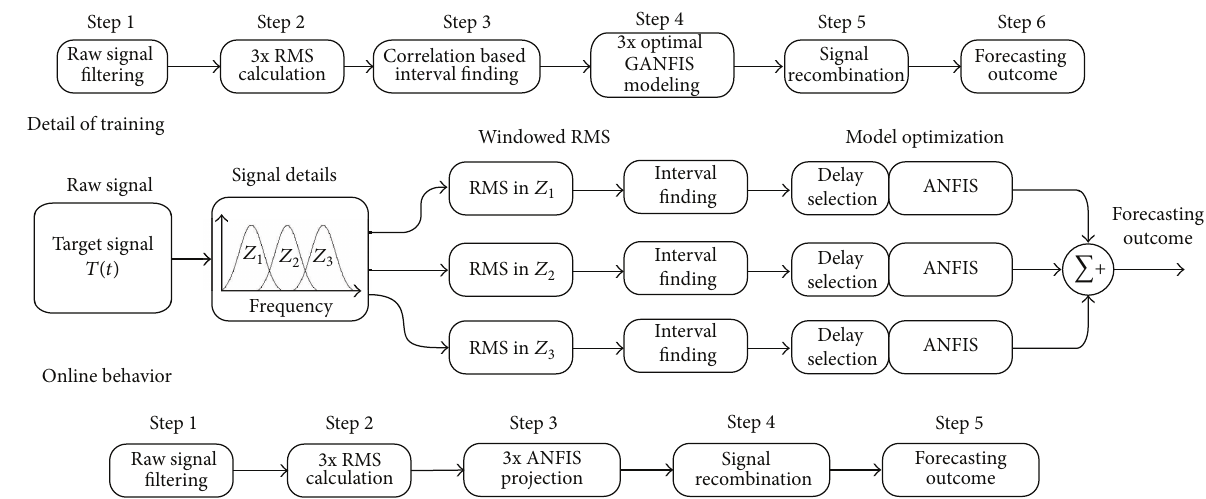
Figure 3: Block diagram of the proposed